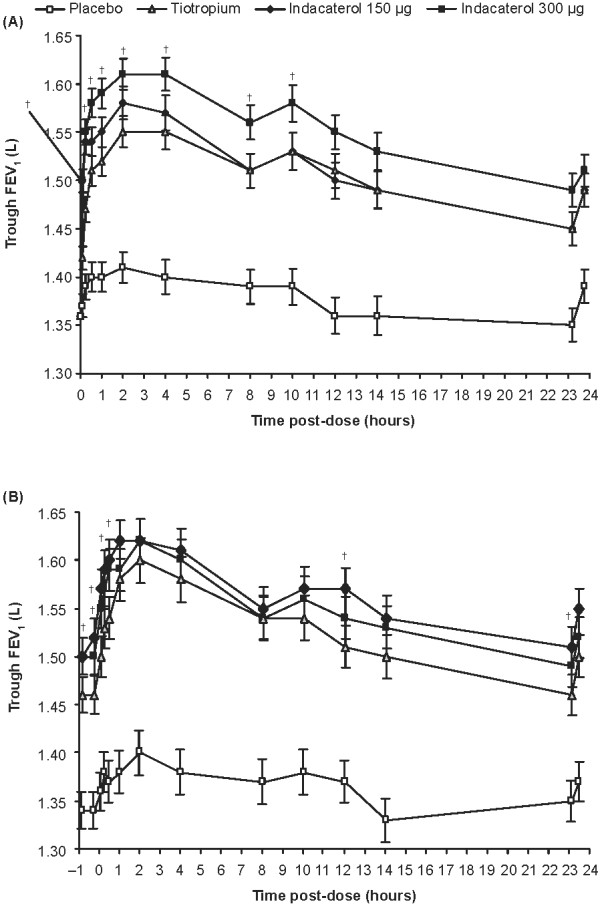
24-h profile of least squares means of FEV1 on Day 1 (A) and 14 (B) (mITT population). A) Data are LSM ± SE. p < 0.001 for indacaterol (150 and 300 μg) vs placebo at each timepoint, p < 0.001 for indacaterol, 150 μg vs tiotropium at 5 and 15 min, †p < 0.05 for indacaterol 300 μg vs tiotropium, p < 0.05 for tiotropium vs placebo at each timepoint. B) Data are LSM ± SE. p < 0.001 for indacaterol (150 and 300 μg) and tiotropium vs placebo at each timepoint, †p < 0.05 for indacaterol 150 μg vs tiotropium at -50 to 30 min, 12 h and 23 h 10 min, p < 0.05 for indacaterol 300 μg vs tiotropium at 5 min